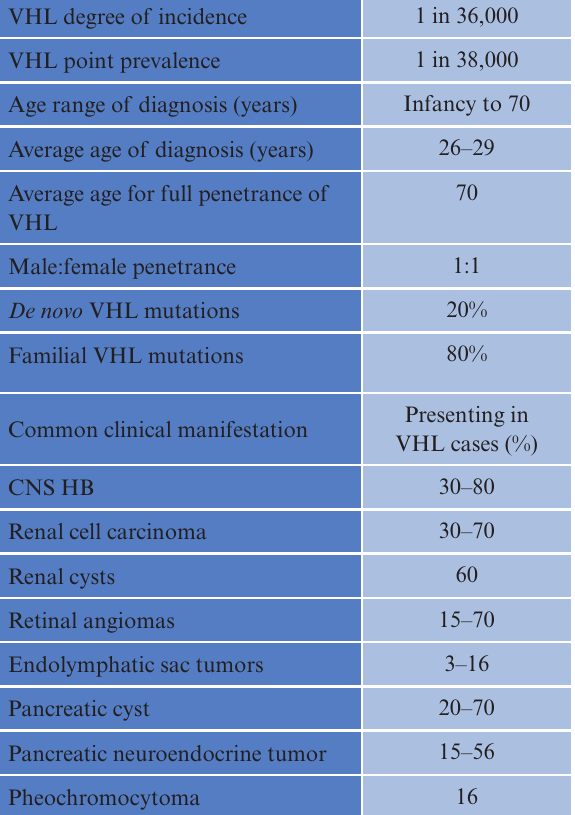
Table 1. Epidemiology-related parameters of VHL VHL degree of